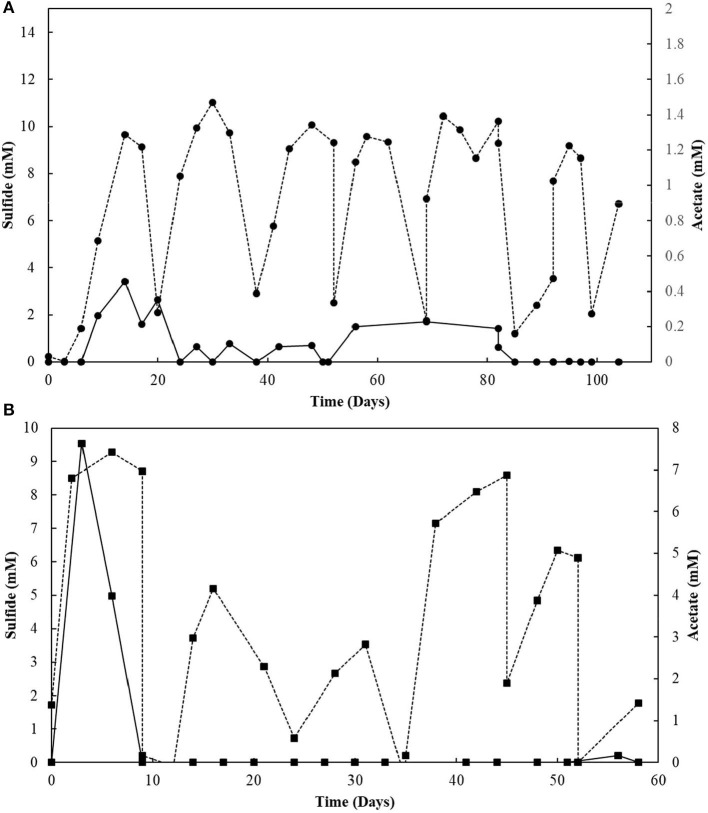
(A) Elemental sulfur and (B) Thiosulfate reactors performance operating in sequencing batch with sulfide stripping. Dashed lines correlate to sulfide, and continuous lines to acetate concentrations.